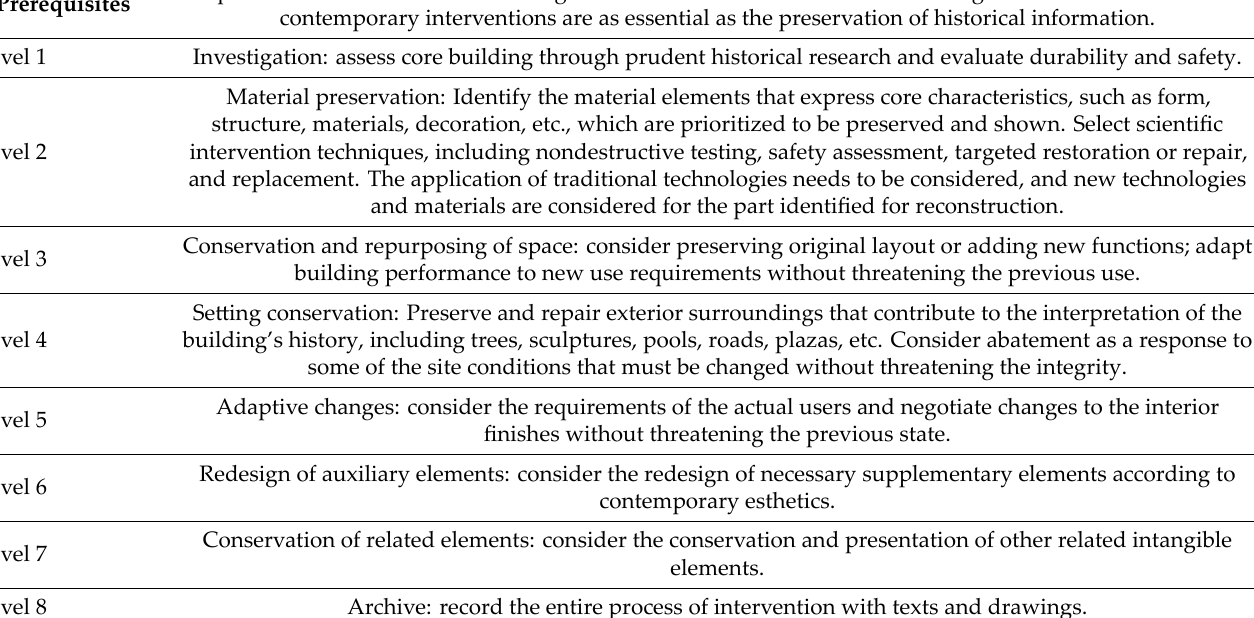
Table 4. An efficient intervention